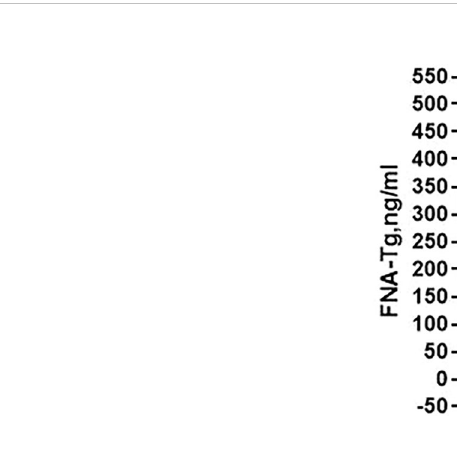
FIGURE 1 The level of FNA-Tg in metastatic and non-metastatic lateral